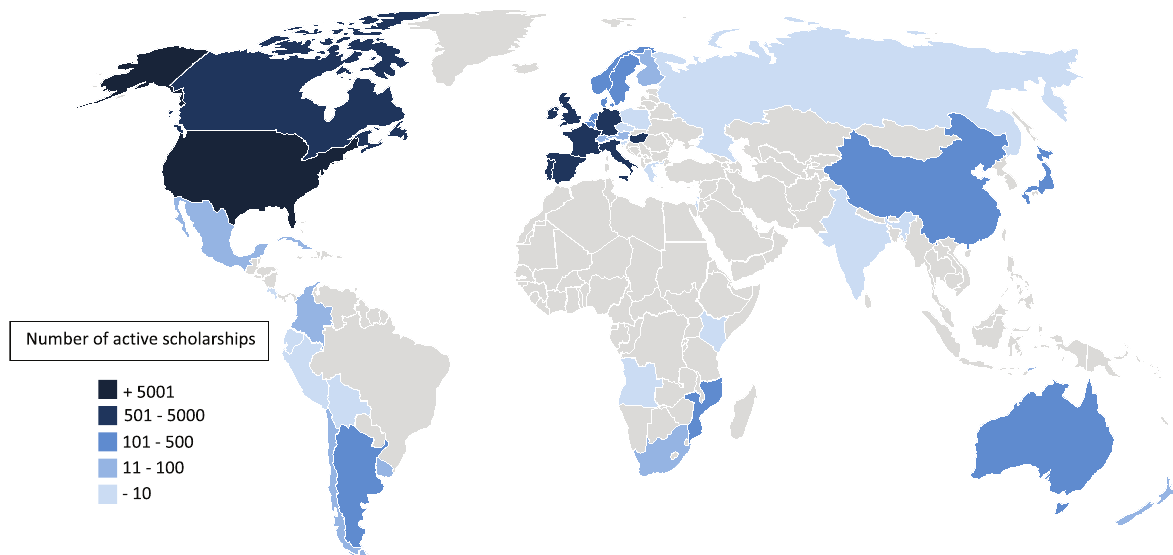
Figure 3 - Active SwB scholarships in 2015.